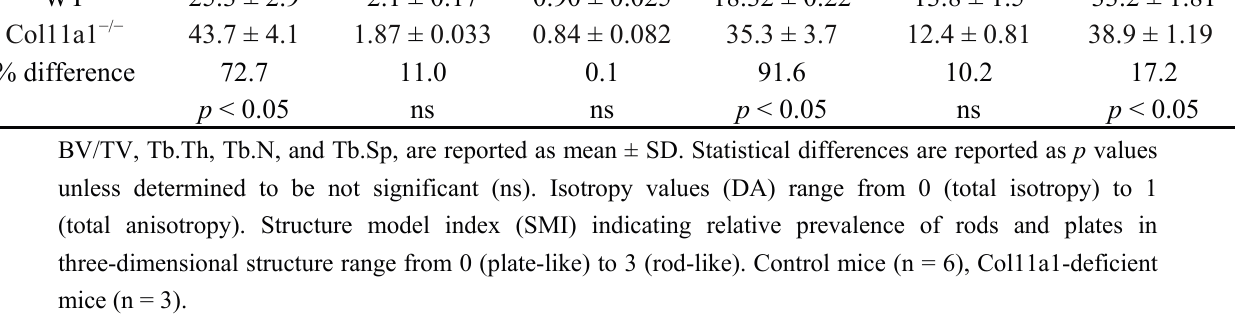
Table 4. Densitometric indices for the humeri (mean + SD) WT and Col11a1 − / − . Genotype BV/TV (%) SMI